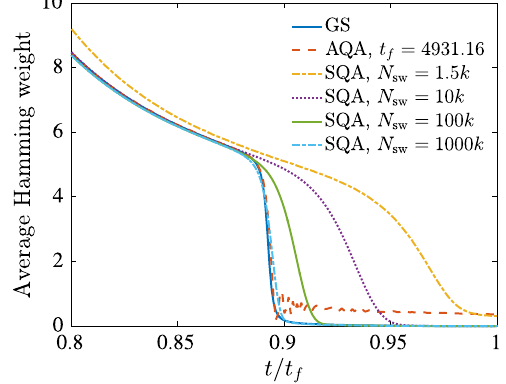
FIG. 9. The expectation value of the Hamming weight operator for the quantum ground state, SQA, and AQA for the fixed plateau problem with n ¼ 512 , l ¼ 0 , and u ¼ 6 and annealing time chosen so as to reach a success probability of 0.9. The expectation value for SQA ( β ¼ 30 , N τ ¼ 64 ) at a given t=t is f calculated by averaging over the Hamming weight of the N τ imaginary-time states at that time and over 10 5 independent trials. The case of 1500 sweeps is the minimum number of sweeps required for SQA (in “ annealer ” mode) to reach the threshold ground-state probability of p 0 ¼ 0 . 9 , and similarly for the 4931 . 16 for AQA. While AQA is annealing time value of t f ¼ able to approximately follow the quantum ground state (i.e., the evolution is very close to being adiabatic), the optimal SQA evolution (i.e., that requires the fewest sweeps) for achieving the threshold criterion involves not following the ground state at the minimum gap point and instead thermally relaxing towards the ground state after this point. As shown using the higher N sw values, only after increasing the number of sweeps by more than 2 orders of magnitude does SQA follow the instantaneous ground state